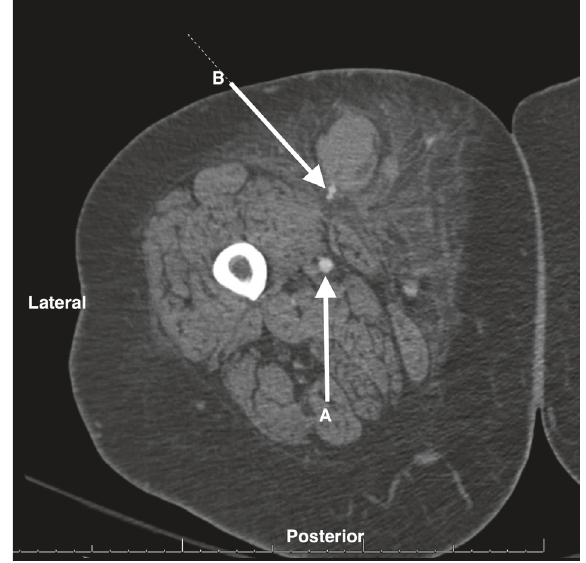
Figure 2: CT angiogram of the patient’s right thigh showing the superficial femoral artery (A) and active extravasation from a small branch of the SFA